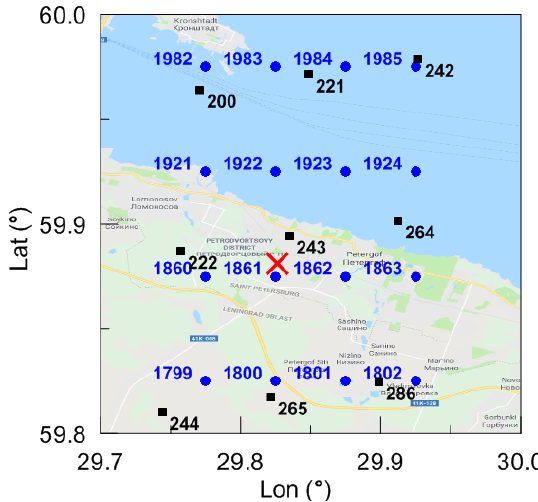
Figure 2. The location and numbers of 9 SEVIRI (black squares) and 16 AVHRR (blue circles) measurement pixels closest to the po- sition of the HATPRO radiometer (marked by the red cross). The small terrain is shown. Map data © 2019